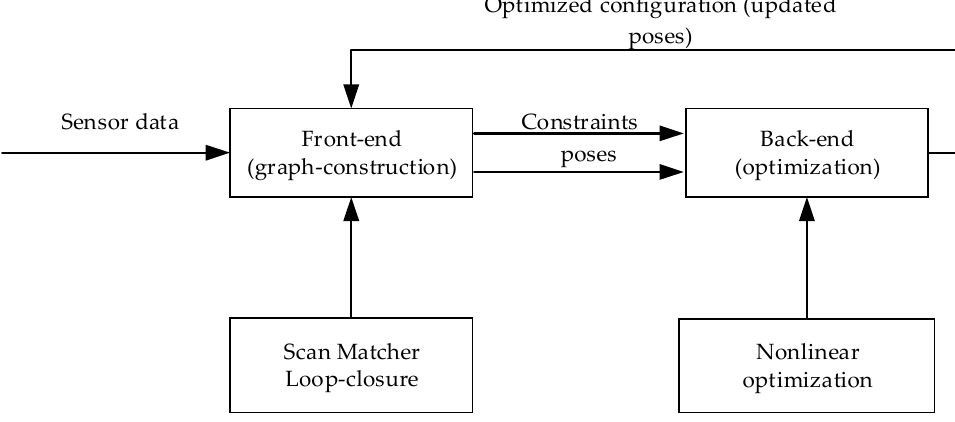
Figure 7. The framework of Karto SLAM.